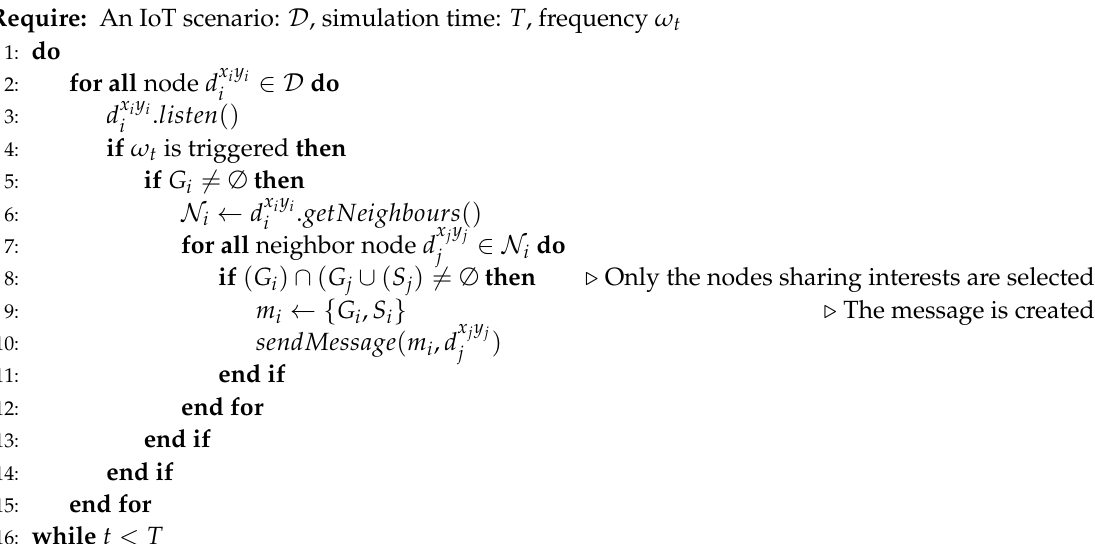
Algorithm 4 SACAR-OCVN